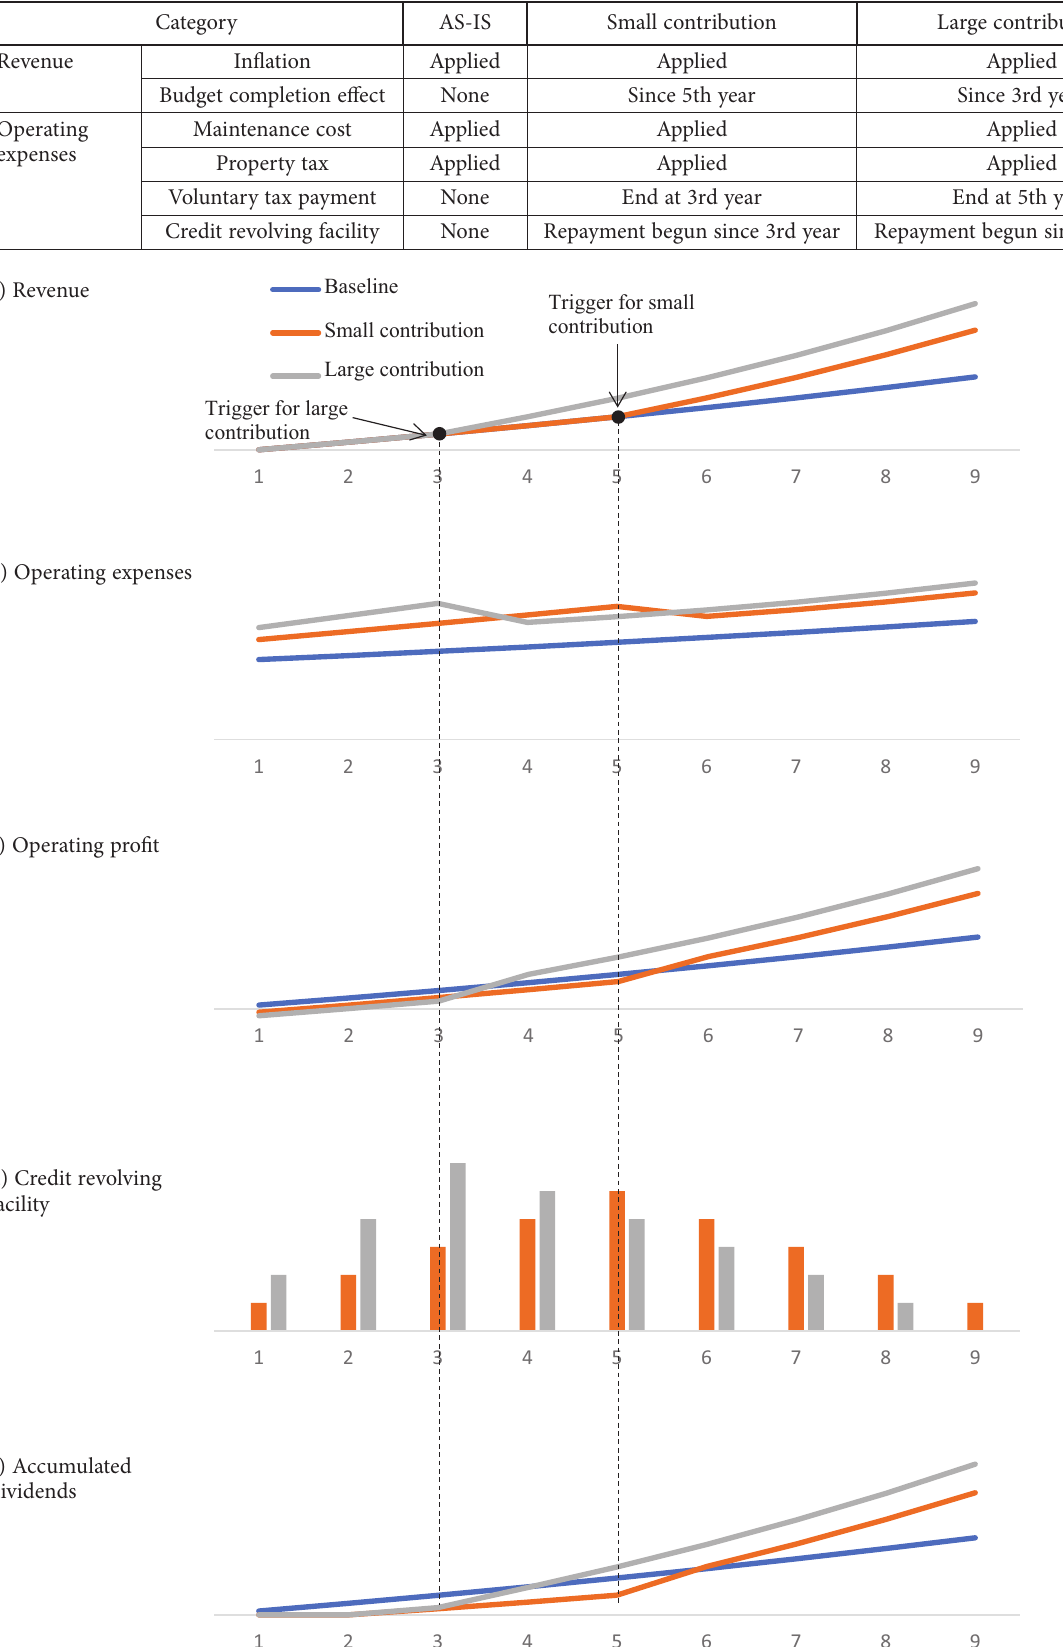
Table 2. Scenario